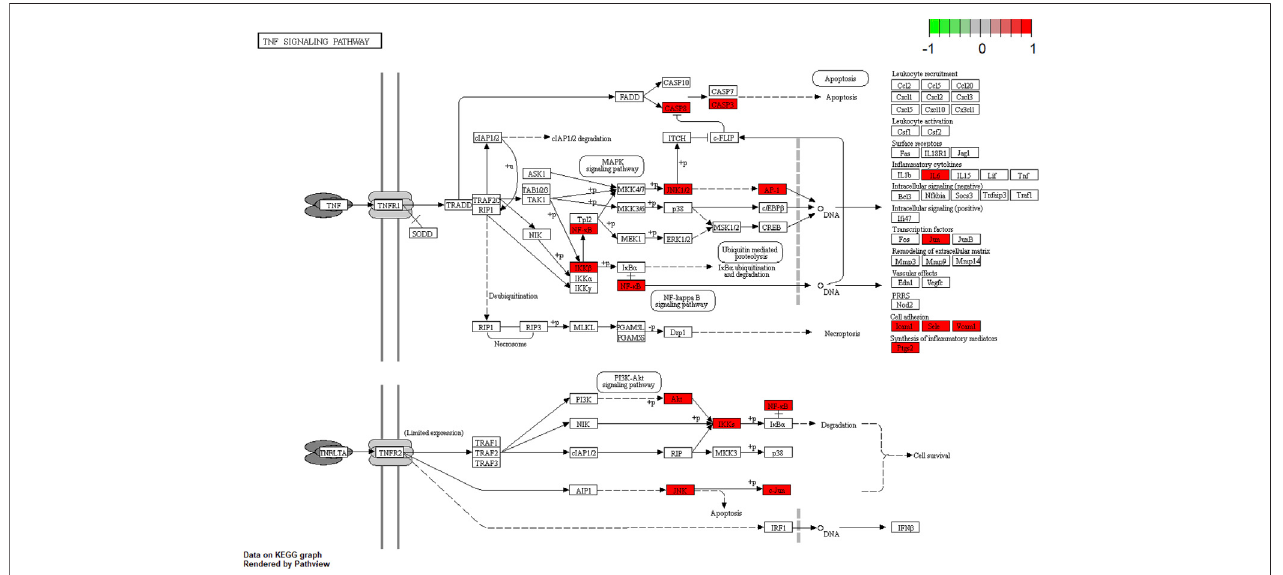
FIGURE6 | TheTNF- α signaling pathway of potential targetgenes ofWP inRA. Arrowsindicate upstream and downstream relationships between genes. The red is a WP target gene in network.